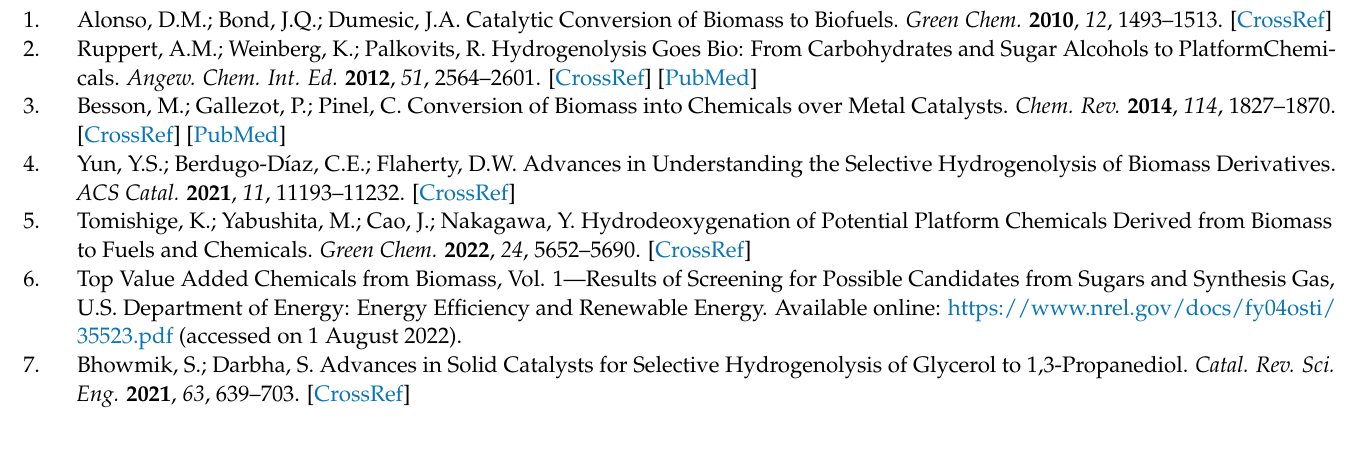
Figure S2: N 2 -physisorption isotherms; Figure S3: High-angle annular dark field image and ele- mental mapping; Figure S4: FT-Raman spectrum of 2Pt/1W/SBA-15; Figure S5: NH 3 -TPD profiles; Table S1: Catalytic activity data for erythritol hydrogenolysis; Table S2: Catalytic activity data of glycerol